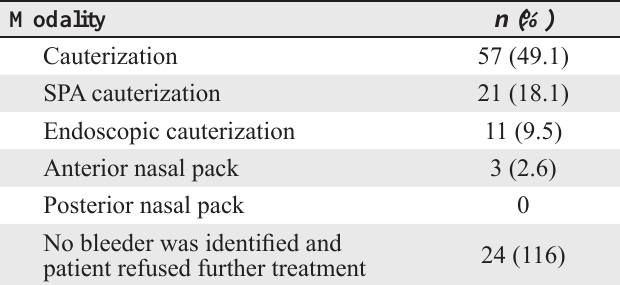
Table 1 : Management modality of Epistaxis (N = 116